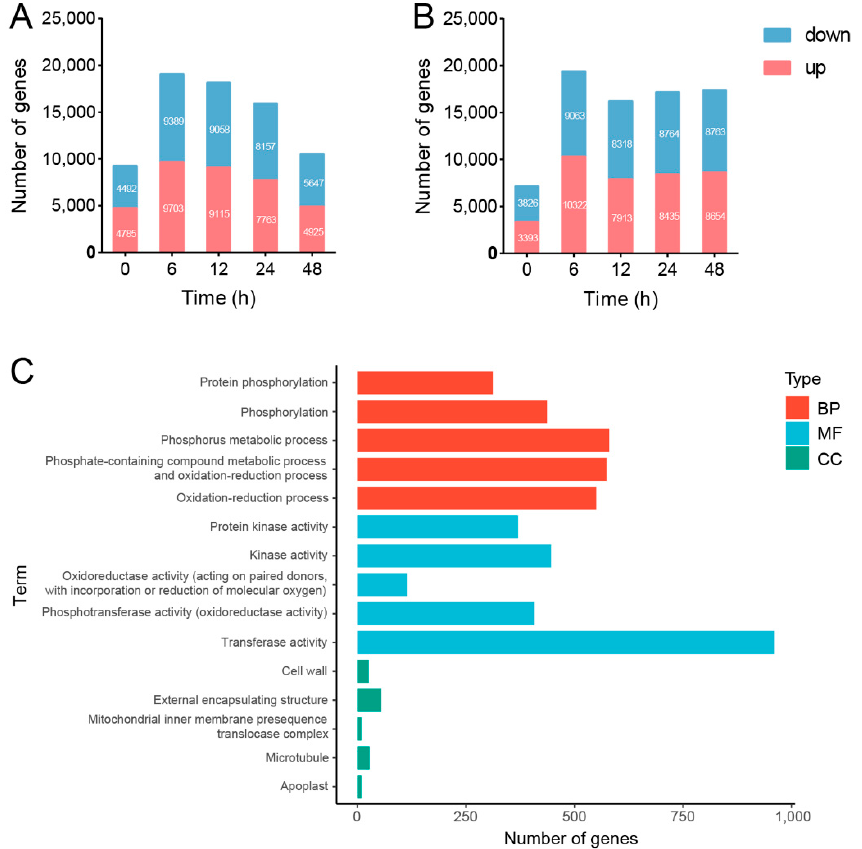
Figure 5. Global view of the differentially expressed genes (DEGs) in SPSCs in response to YE. ( A ) The number of DEGs between NT_T and NT_NT. ( B ) The number of DEGs between NT_T and PT_T. ( C ) GO term enrichment of DEGs between NT_T and NT_NT (TOP 5). BP, biological process; CC, cell component; MF, molecular function.